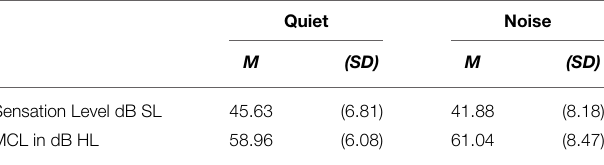
TABLE 4 | Intensity level of stimuli